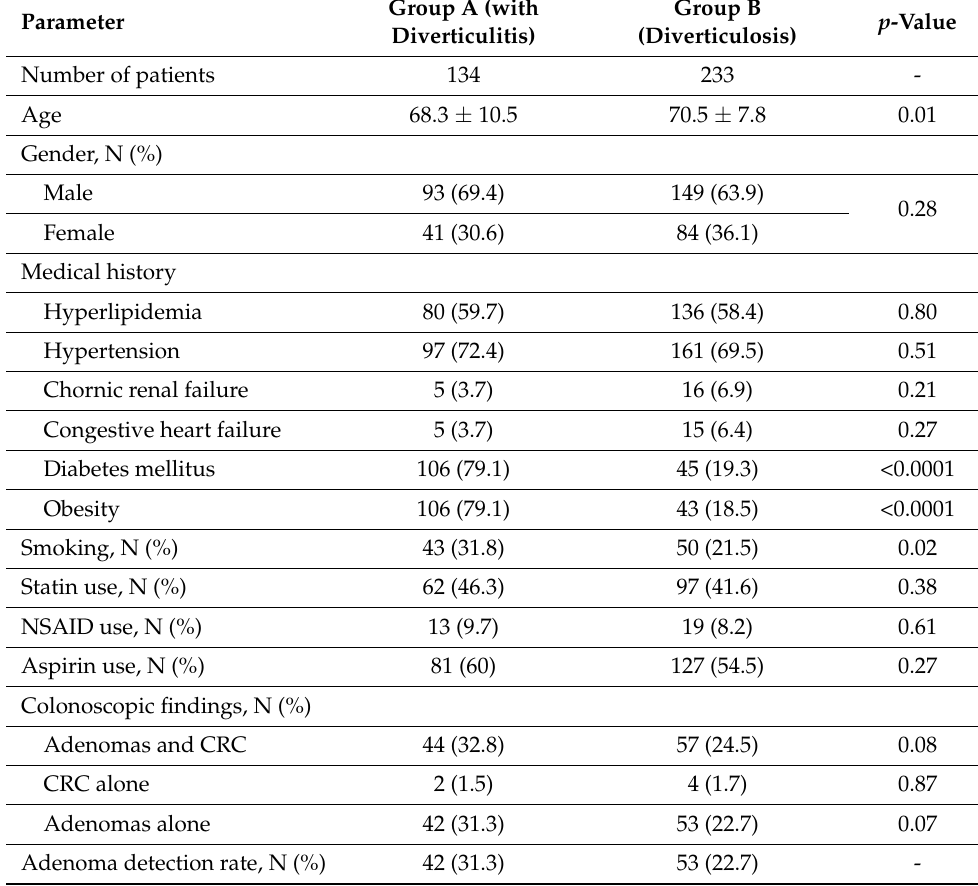
Table 1. Demographics, baseline characteristics, and colonoscopic findings.